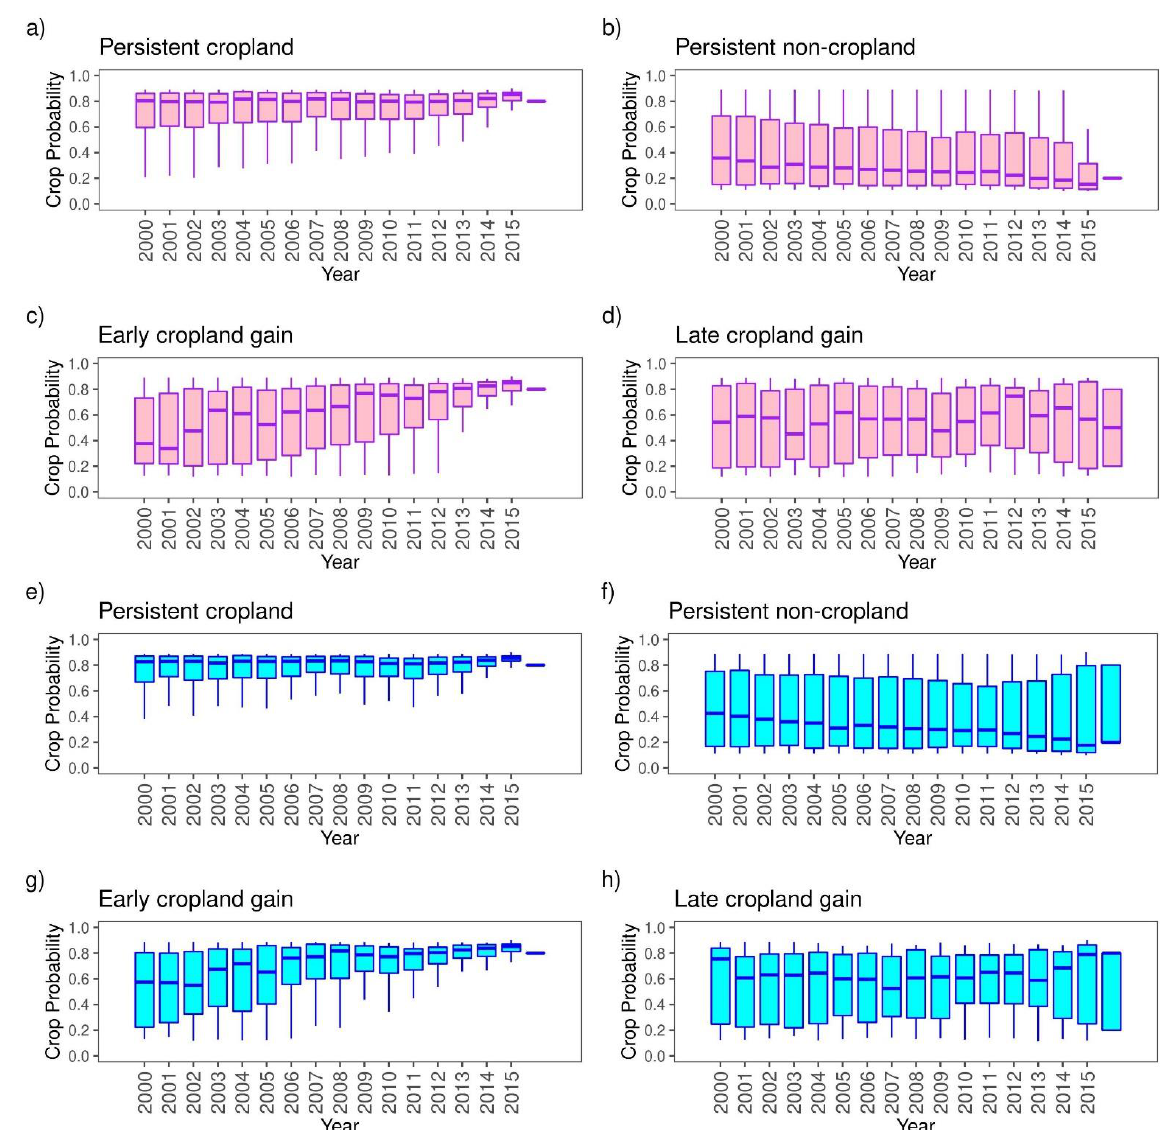
Figure 8. Probability trajectories within four change-based classes in cropland wins reference dataset: ( a ) Persistent Cropland; ( b ) Persistent Non-Cropland; ( c ) Early Cropland Gain (expansion between 2000 – 2010); ( d ) Late Cropland Gain (expansion between 2010 – 2015). The probability trajectories within the same four classes, as assessed with the majority agreement reference dataset, are shown in subplots ( e – h ). Cropland probabilities are summarized as box plots for each year in the time series, with the bar indicating the median probability in each time period, the upper and lower ends of the box showing the 75th and 25th percentile of probabilities, and the whiskers showing 1.5 times the interquartile range. The initial probability distributions on the right side of each plot are drawn from the probability value assigned to the two GSFAD classes (0.8 for cropland, 0.2 for non-cropland) prior to BULC-U updating.